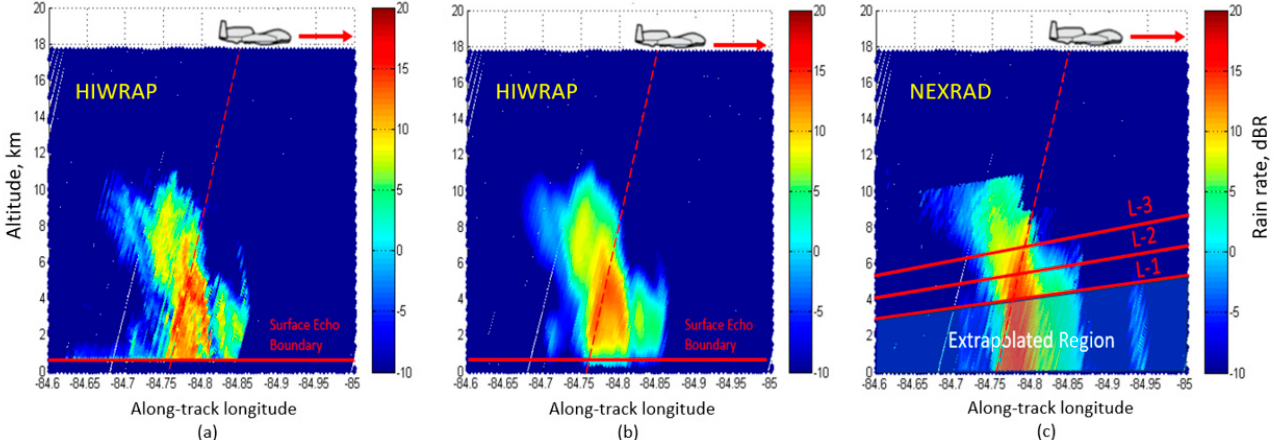
Figure 11. HIWRAP and NEXRAD aft looking outer beam vertical rain rate profiles along the aircraft ground track, where rain intensity color bar is in dBR and the red boundary is the minimum detectible height due to surface echo contamination. Panel ( a ) is HIWRAP, panel ( b ) is HIWRAP convolved with NEXRAD IFOV, and panel ( c ) is NEXRAD.